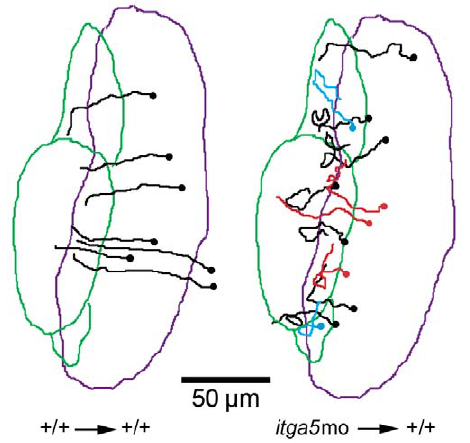
Figure 4. Cell-autonomous requirement for Itga5 in otic/ epibranchial cells. ( A ) Trajectories of cells transplanted from a wild type donor into a wild type host and tracked by time-lapse from 11.5– 14.5 hpf. Data show tracks of 7 cells from a single embryo. ( B ) Trajectories of cells transplanted from itga5 morphant donors into wild type host embryos and tracked by time-lapse from 11.5–14.5 hpf. A total of 16 cells from 3 embryos were tracked, though some were not included on the map to avoid confusion. Red tracks represent cells that underwent lysis during the time-lapse. The purple and green boundaries represent the initial and final pax2a domain during time- lapse recording. Dots represent the initial positions of cells. Images show dorsal views with anterior to the top. Scale bar, 50 m m.